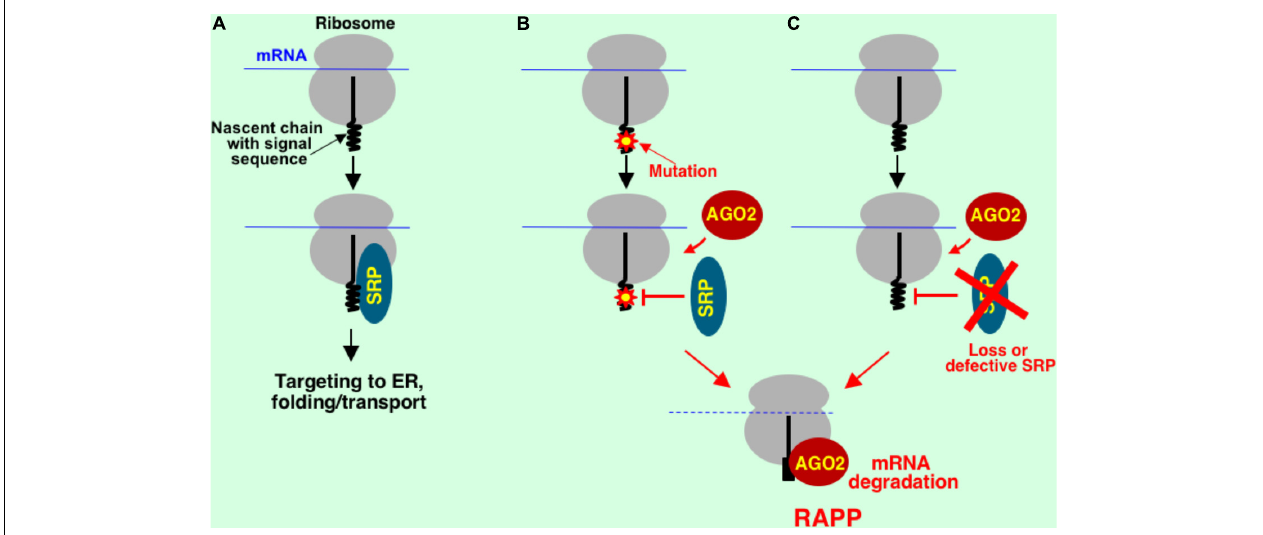
FIGURE 4 | Model for regulation of aberrant protein production (RAPP) in mammalian cells. Normal cotranslational interactions are important for protein biogenesis. Nascent chains of secretory proteins interact with signal recognition particle (SRP). This interaction leads to proper protein targeting to ER, folding and transport (A) . Loss of this normal interaction with SRP due to a critical mutation in the secretory protein (B) or loss of the interacting factor (C) leads to engagement of AGO2 (a protein involved in translational silencing). This interaction directs aberrant protein mRNA for degradation initiating the RAPP